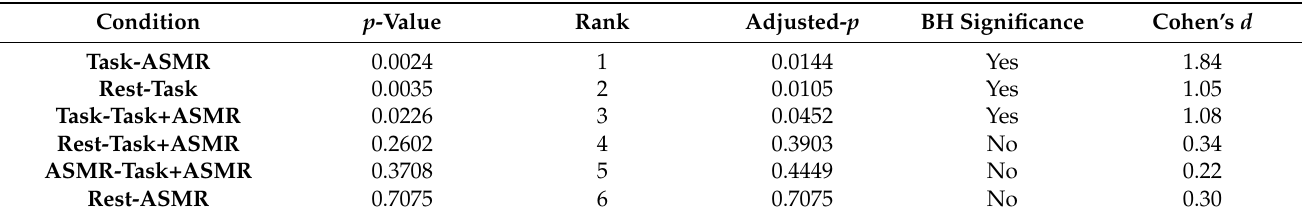
Figure 5. Average power spectral response for gamma band activity in each experimental condition. Gray and black-filled circles are individual and averaged responses, respectively. Asterisks * indicates p < 0.05 as evaluated by Wilcoxon ranked sum test with adjusting by Benjamini-Hochberg methods. Depicted in the same format as Figure 4. Table 2. Statistics results for gamma-band avidity of with adjusting by Benjamini-Hochberg meth- ods (FDR < 0.05).